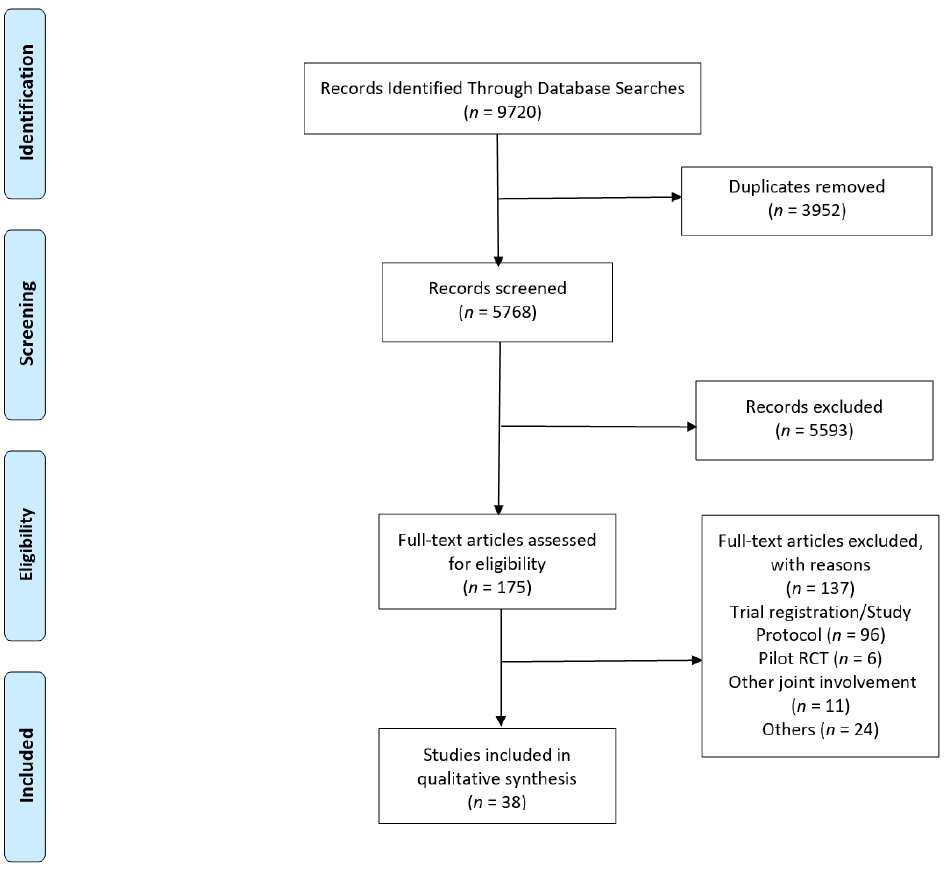
Figure 1. PRISMA flowchart. Table 2. Summary of